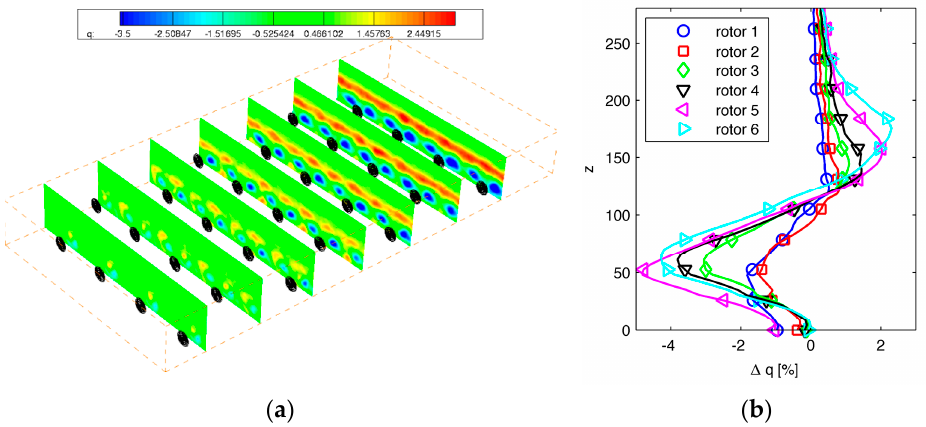
Figure 3. ( a ) Contour plots of time-averaged RH difference in vertical plane slices at fixed downstream distances within a staggered array; ( b ) Variation of the RH with vertical direction (reprinted with permission from [36]).